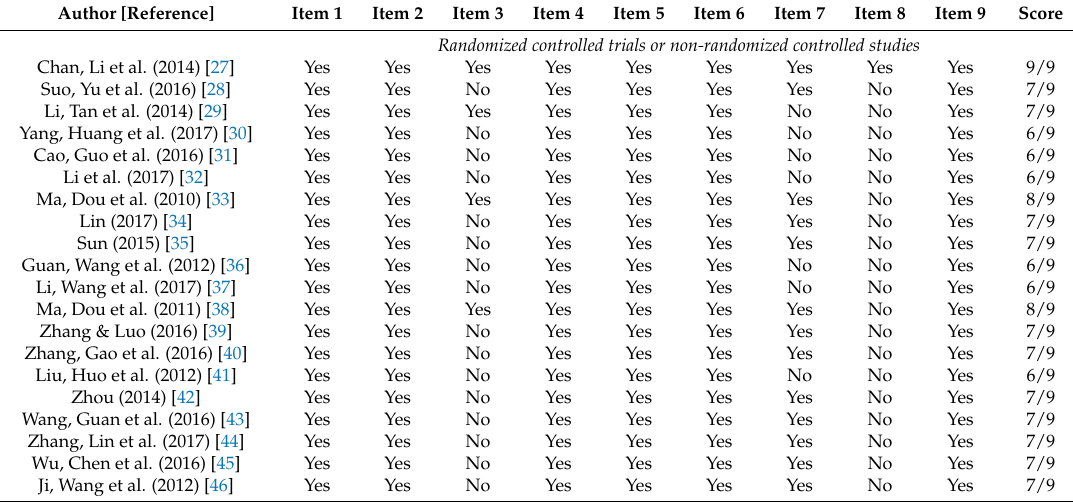
Table 3. Methodological quality for randomized controlled trials and non-randomized controlled